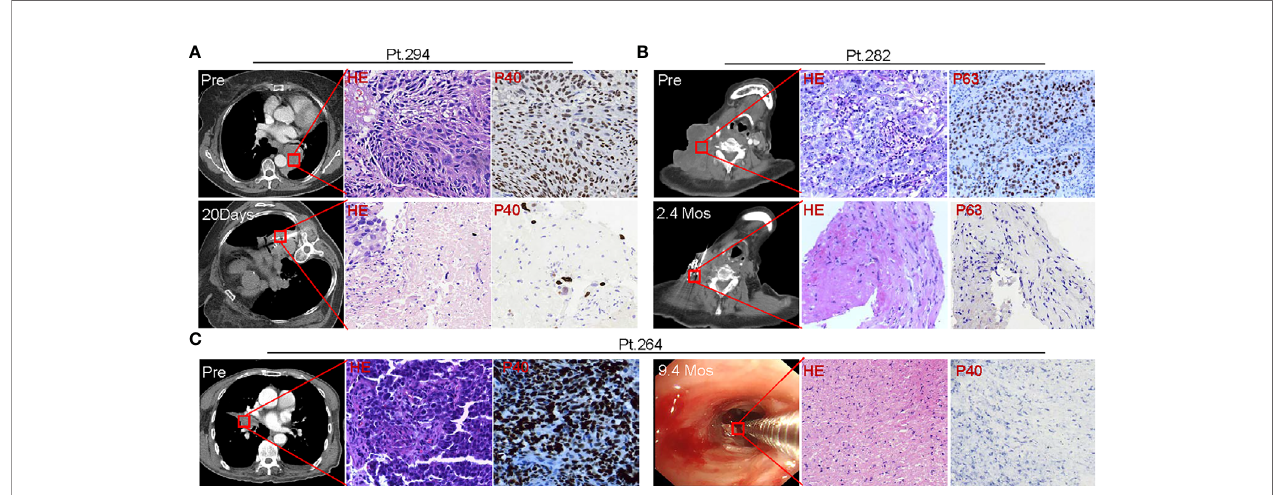
FIGURE 9 | Tumor pathologic alterations following SNCP- 125 I brachytherapy. (A) Pre-treatment needle biopsy of the lung mass in Patient 294 showed a moderately differentiated squamous cell carcinoma, and immunostain for p40, a speci fi c marker for squamous cell carcinoma, showed strong and diffuse nuclear expression in squamous cell carcinoma. 20 days post 125 I seed brachytherapy, a needle biopsy within one 1cm of the seed implantation site showed scant clusters of residual cancer cells surrounded by amorphous necrotic tissue, ghost tumor cells and in fl ammatory cells. Residual cancer cells exhibited cytological atypia, in line with a radiation treatment effect, including enlarged hyperchromatic nuclei, multiple nuclei, cytoplasmic vacuoles. p40 staining highlights the residual cancer cells. (B) Pre-treatment resection biopsy of a massive metastatic cervical lymph node in Patient 282 showed poorly differentiated squamous cell carcinoma, and p63 immunostain showed strong and diffuse nuclear expression in squamous cell carcinoma cells. 2.4 months post 125 I seed implant, a needle biopsy within one 1cm of the seed implantation site, showed spindle fi broblasts, amorphous collagen tissue, and scattered in fl ammatory cells. There were no visible residual cancer cells on H&E stain slides. p63 staining identi fi ed no residual cancer cells. (C) Pre-treatment bronchoscopic biopsy of the lung mass in Patient 264 showed poorly differentiated basaloid squamous cell carcinoma, and strong and diffuse nuclear stain pattern showed p40 expression in squamous cell carcinoma. At 9.4 months post 125 I seed implant, a bronchoscopic biopsy at the previous biopsy site showed fi brotic tissue, great in fi ltration of in fl ammatory cells, and necrotic surface indicative of ulcer. There were no visible residual cancer cells or normal epithelial cells lining the bronchus surface on H&E stain slides. p40 staining identi fi ed no residual cancer cells. All images were taken in a 40X magni fi cation. HE, hematoxylin and eosin staining. 8 patients were tested and 3 patients were shown here as representative